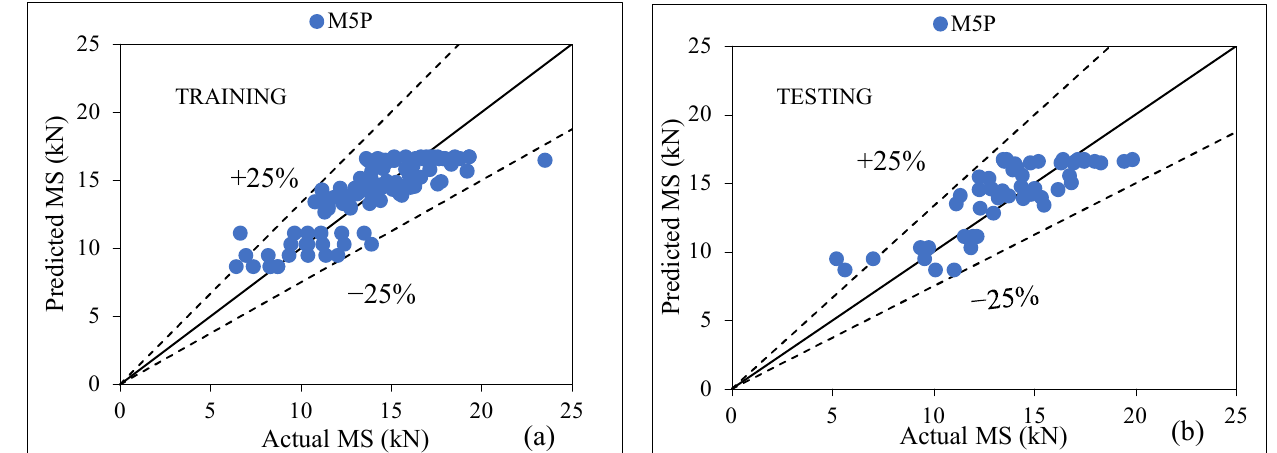
Figure 7. ( a , b ) Agreement graph showing actual vs. predicted values of MS by using an M5P tree-based model for both stages.